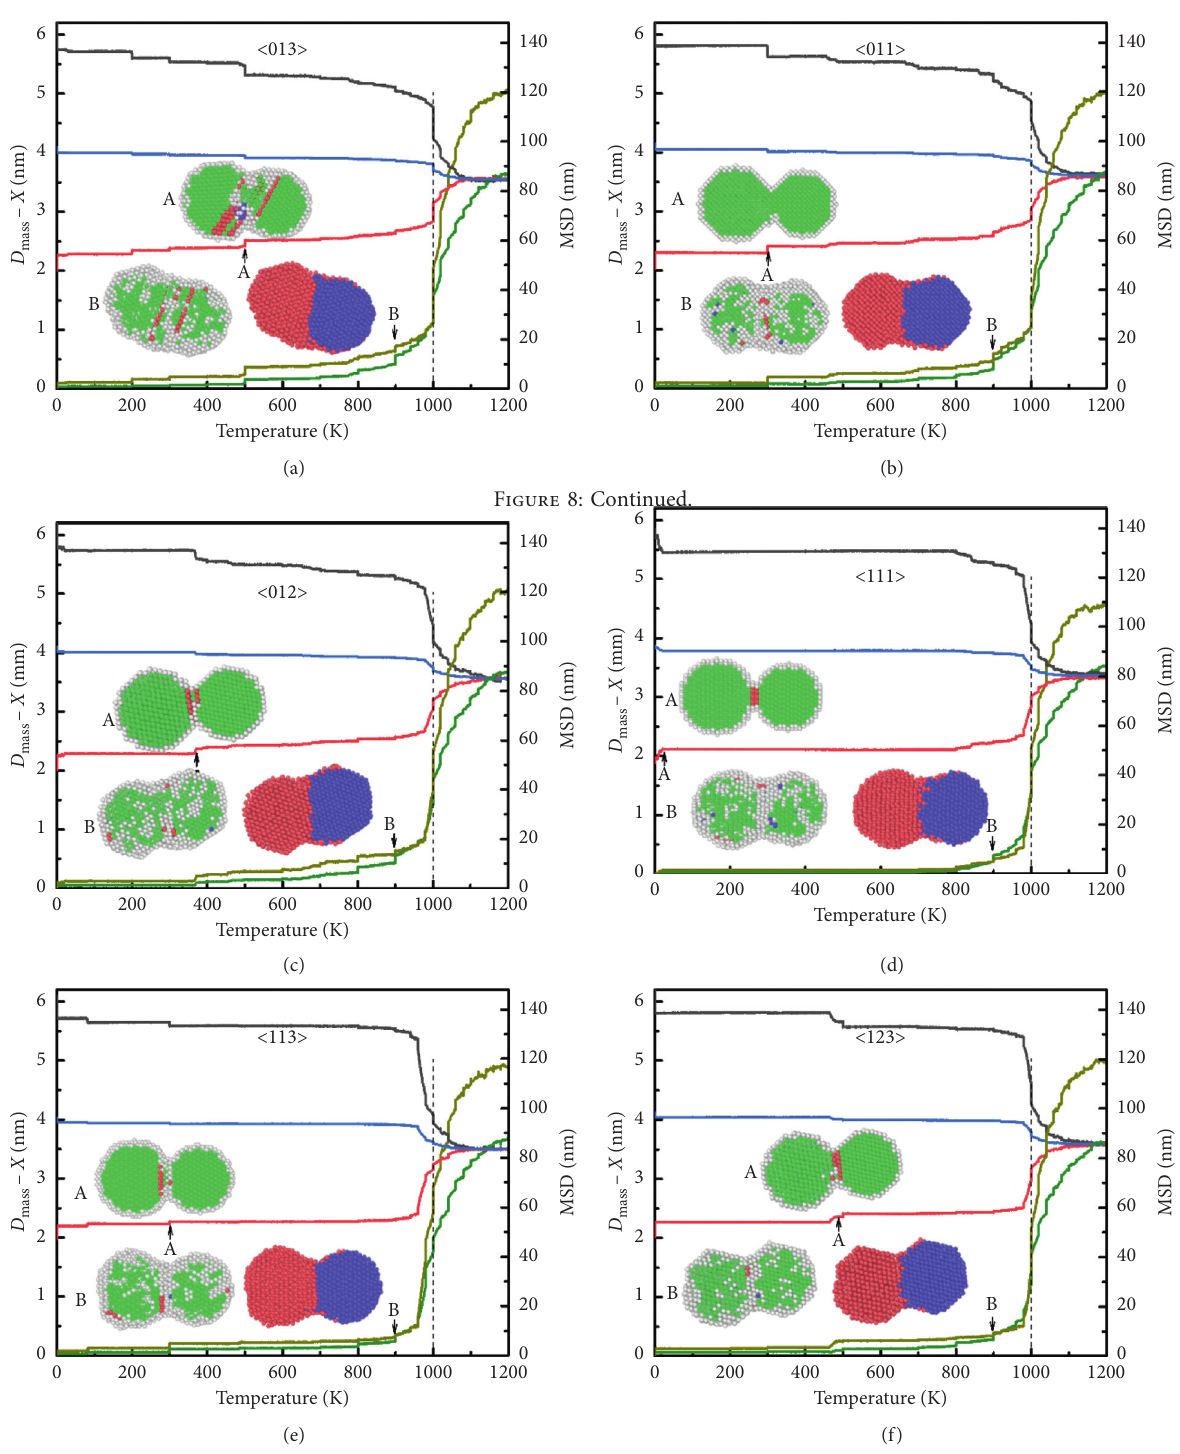
Figure 8: The D − X and MSD curves and cross section of snapshots, (a),(b), (c), (d), (e) and (f) are corresponding to CuAg-4nm with mass arrangement of < 013 > , < 011 > , < 012 > , < 111 > , < 113 > and < 123 > ,